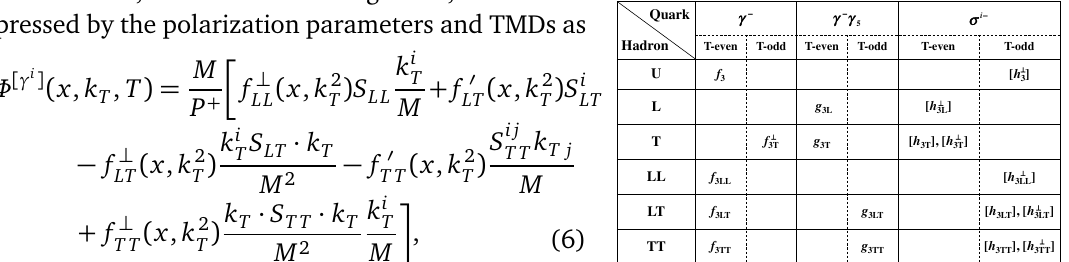
Table 3: Twist-4